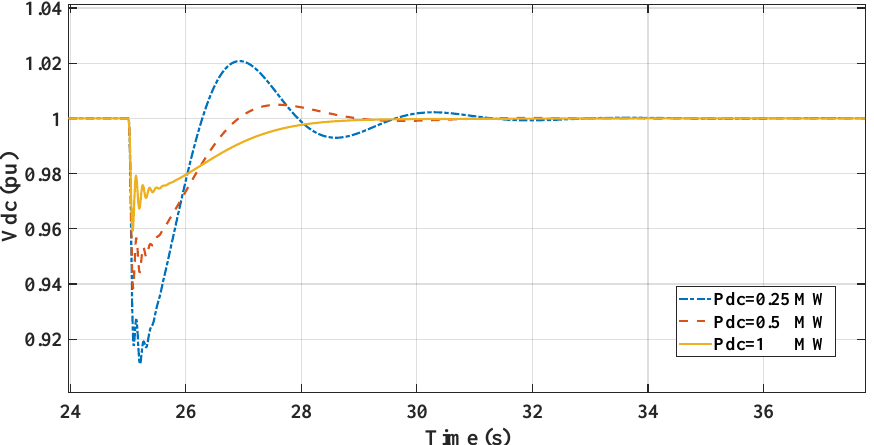
Figure 17. Power transfer from DC to AC grid at different DC-microgrid loadings.